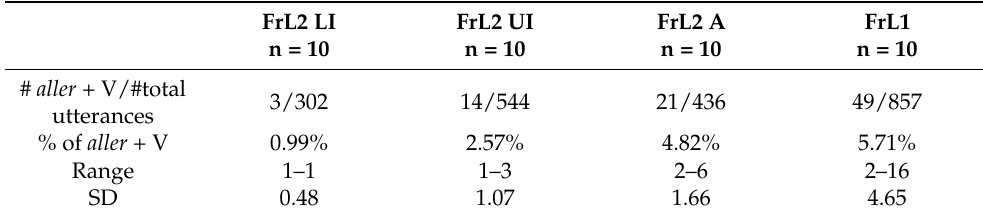
Table 2. Distribution of aller + V forms in Reksio